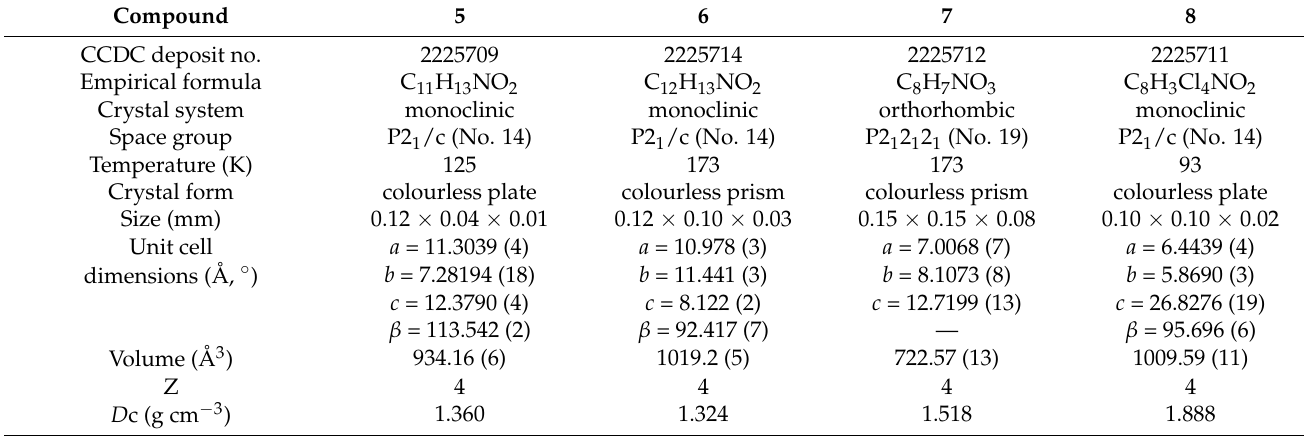
Table 2. Summary of crystallographic data obtained for compounds 5–8